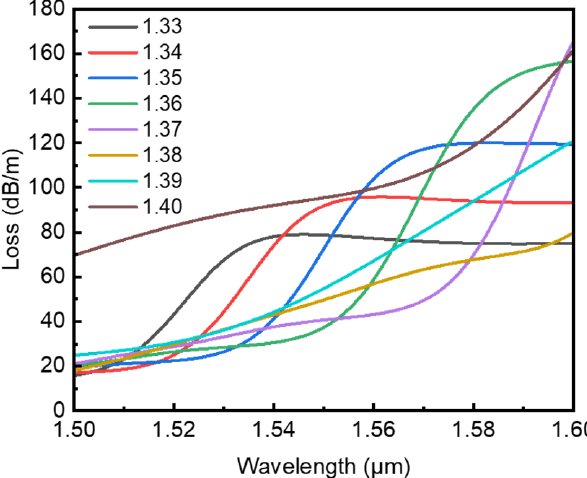
Figure 7. Confinement loss versus wavelength with analyte refractive index changing from 1.33 to 1.40 for twist rate A = 12.1 cm − 1 .